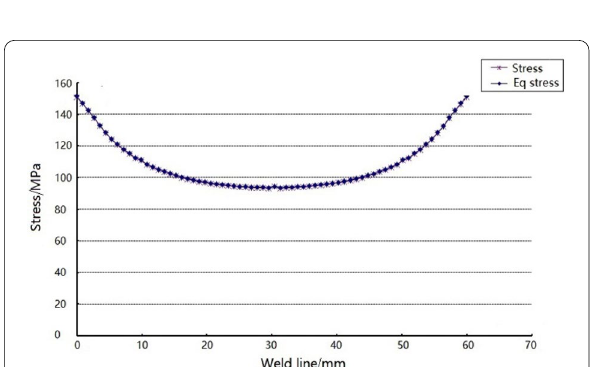
Figure 23 Calculated structural stress of butt weld sample with 6005 aluminum